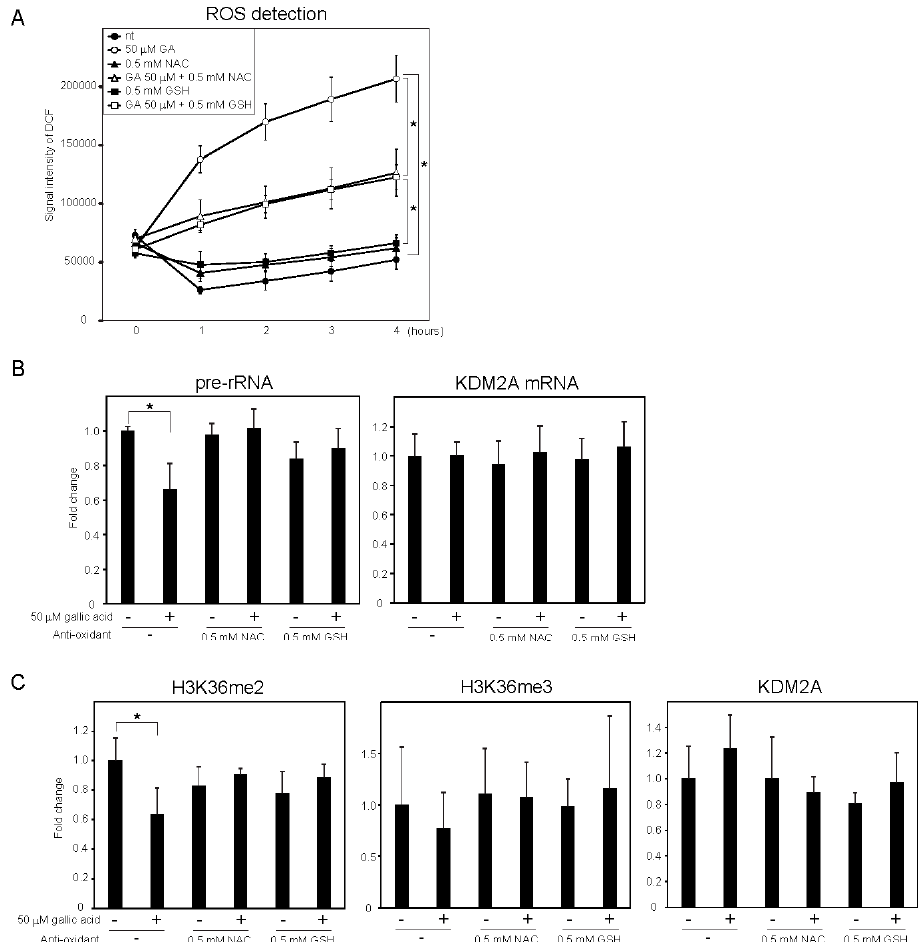
Figure 2. ROS production by gallic acid was required for the repression of rRNA transcription mediated by KDM2A in MCF-7 cells. ( A ) Gallic acid increases ROS production in MCF-7 cells. MCF-7 cells cultured with cell-permeable ROS probe DCFDA were cultured with or without 50 µM gallic acid (GA) in the presence or absence of 0.5 mM N -acetyl- L -cysteine (NAC) or L -glutathione (GSH). At the indicated times, the increases in the signal intensities of DCF by ROS in cells were measured. ( B ) Effects of anti-oxidants, NAC and GSH, on the reduction of rRNA transcription by gallic acid. MCF-7 cells treated with or without 50 µM gallic acid in the presence or absence of 0.5 mM NAC or 0.5 mM GSH for 4 h. Total RNAs were isolated and analyzed by qRT-PCR to detect pre-rRNA (left panel) and KDM2A mRNA (right panel). The ratios of the values for cells treated with various conditions to those for cells treated without gallic acid and anti-oxidants are shown. ( C ) Effects of anti-oxidants, NAC and GSH, on the reduction of H3K36me2 marks in the rDNA promoter by gallic acid. MCF-7 cells were cultured for 4 h with or without 50 µM gallic acid in the presence or absence of NAC or GSH. The levels of H3K36me2, H3K36me3, and KDM2A in the rDNA promoter were analyzed by ChIP assays. The results are expressed as fold changes to the values in various conditions to those without gallic acid and anti-oxidants. All experiments were performed more than three times, and the mean values with standard deviations are indicated. *; p < 0.05.